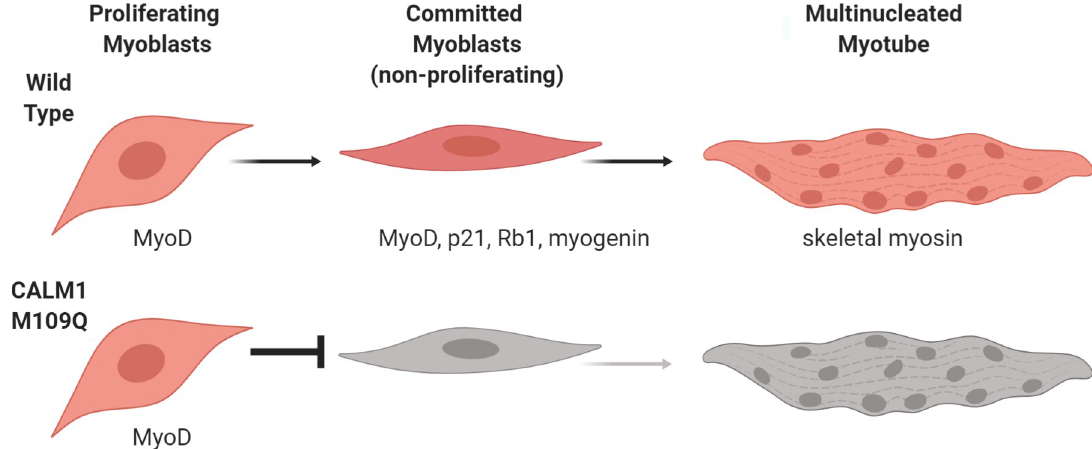
Fig 4. CaM acts as a potent cellular redox sensor that regulates myogenesis. The CALM1 M109Q mutation, which mimics methionine oxidation at M109, blocks myogenesis before myoblasts exit from the cell cycle and commit to differentiation.